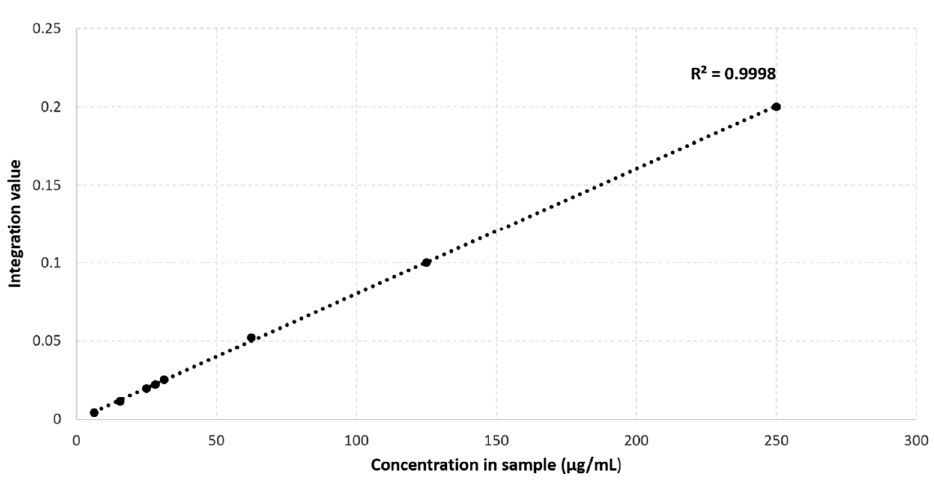
Figure 2. Calibration curve of maleic acid in human plasma containing 4 mM TSP.